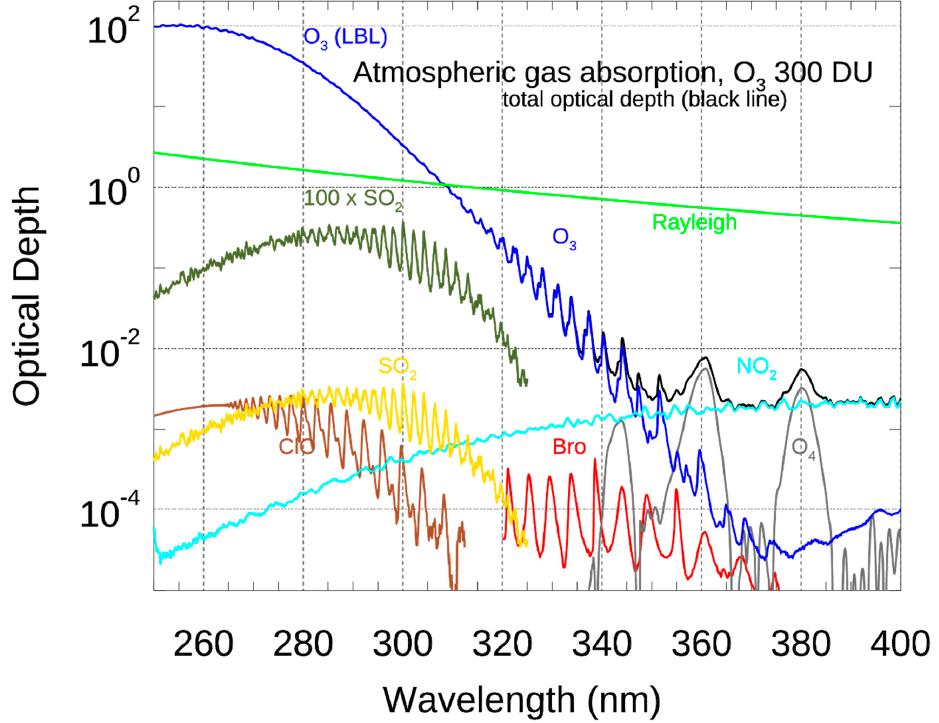
Figure 3. Optical depths of absorbing gases: O 3 , SO 2 , NO 2 , O 4 , Bro, and ClO for U.S. standard atmosphere. The column ozone amount is 300 Dobson Units.